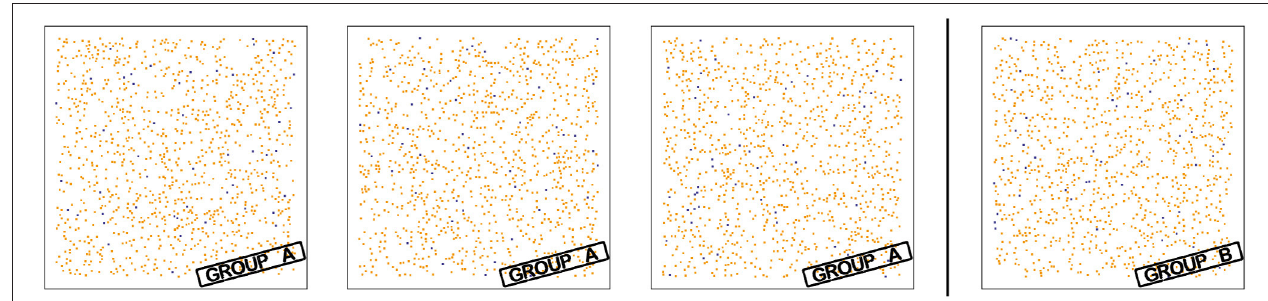
FIGURE 4 | Slides for verification experiment. The synthetic slides using 1mm 2 tissue in two groups are constructed such that the fraction of Ki67 objects (orange) within 15 µ m of the closest proliferating CD8 object (dark violet) differs the two groups: This fraction is 0 in group A and ≥ 0.01 in group B. The digital approach successfully discriminates the visually similar